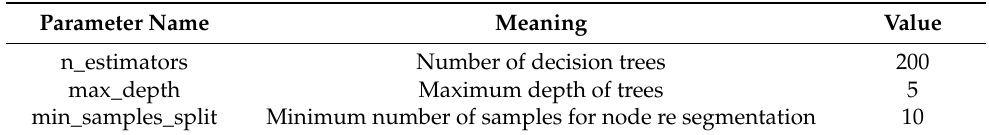
Table 6. Random forest parameter settings.